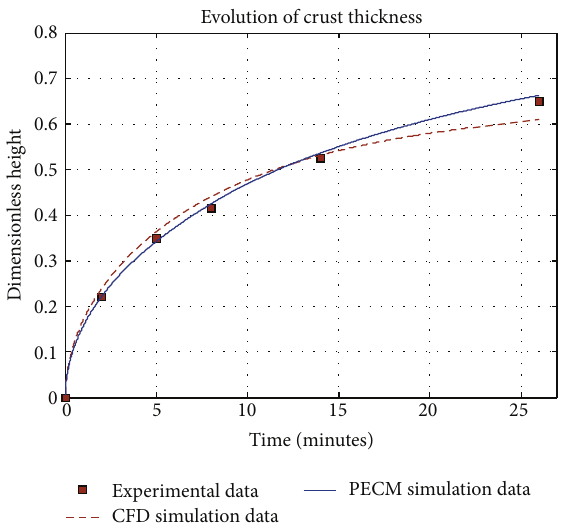
Figure 13: Average PECM, CFD predicted, and experimental crust thickness evolutions.